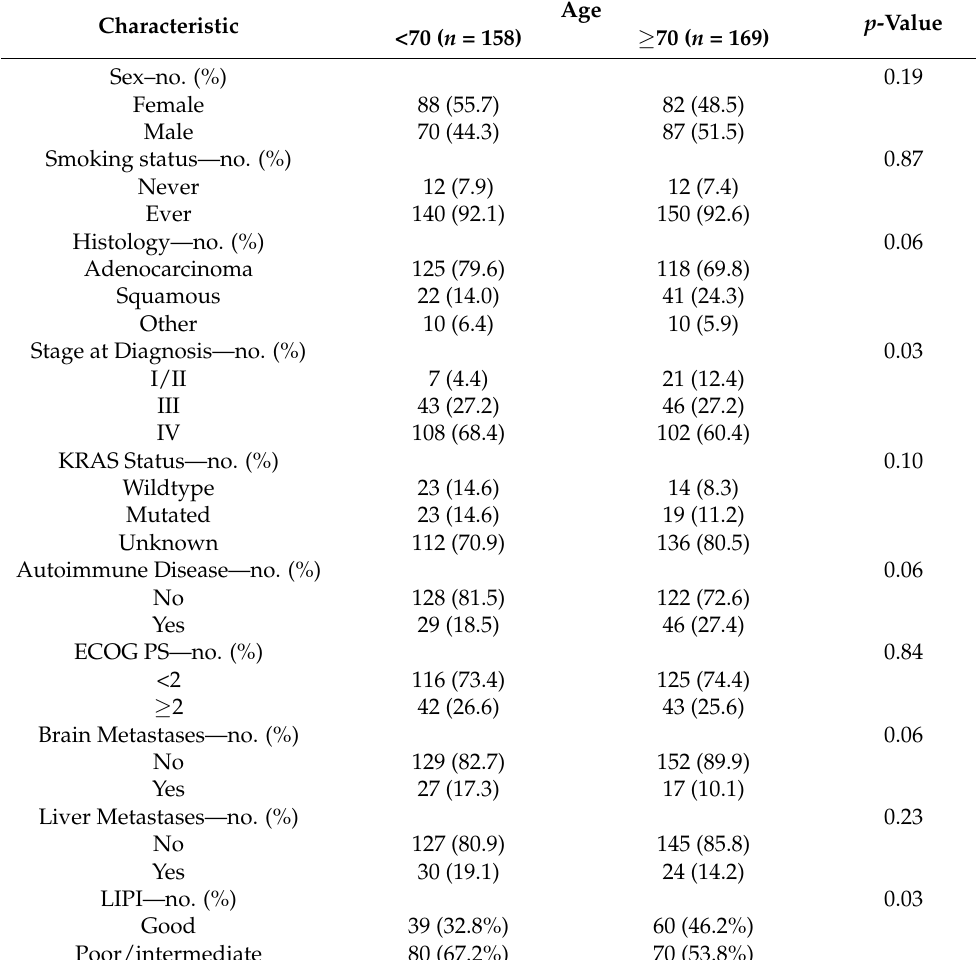
Table 1. Distribution of the baseline clinical and pathological characteristics by age.